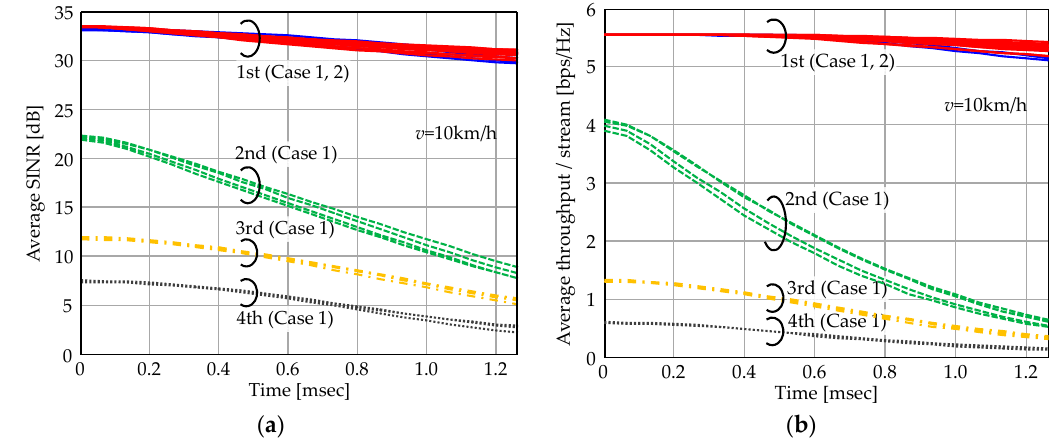
Figure 4. Time variant characteristics within the CSI estimation period. Case 1: Nu = 4, Ns = 4; Case 2: Nu = 16, Ns = 1. ( a ) Average SINR per stream versus elapsed time. ( b ) Average throughput per stream versus elapsed time.